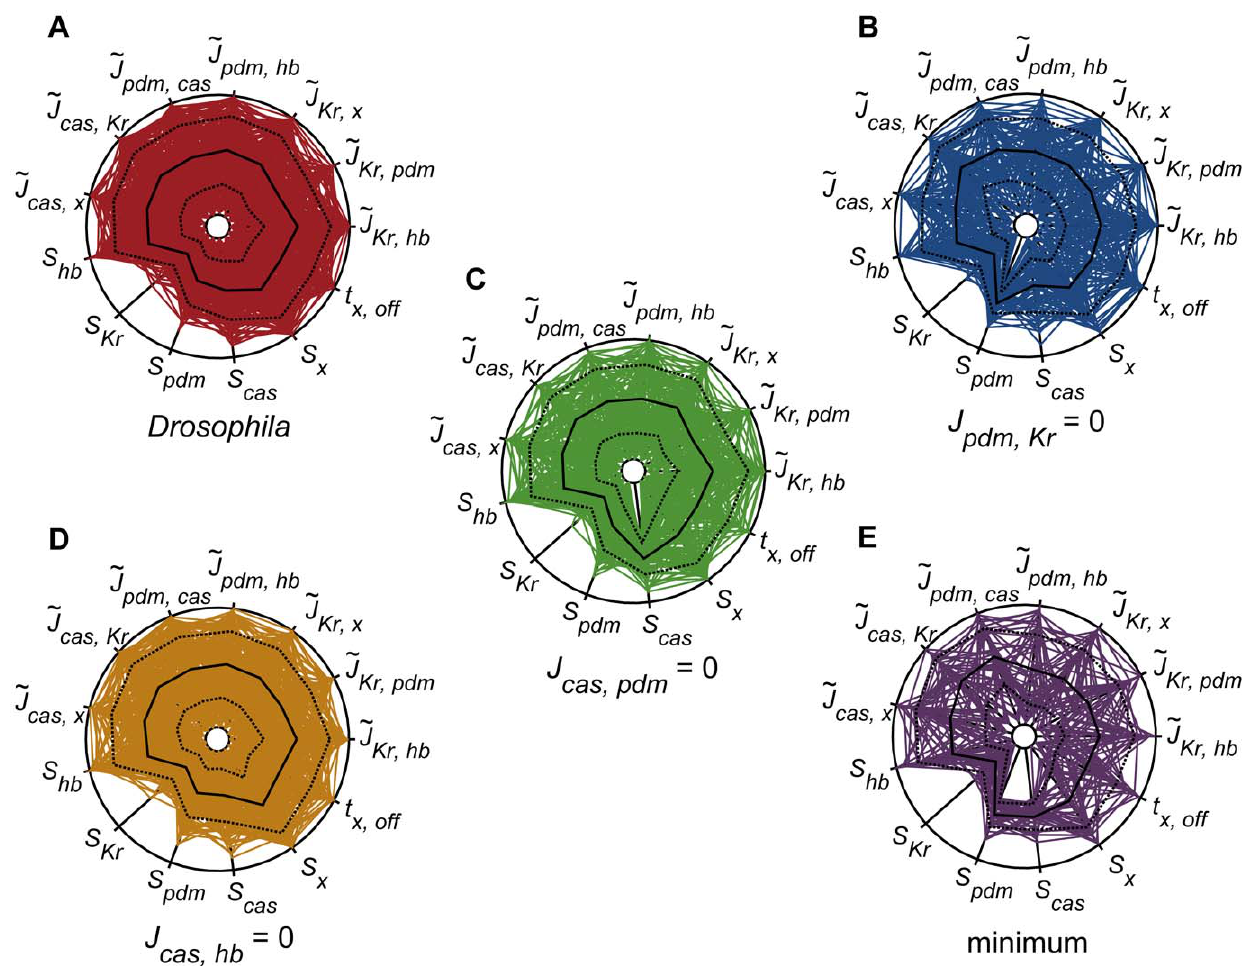
Figure 7. Graphical representation of parameter sets with which the WT sequential expression profile is reproduced. ( A ) The Drosophila network, the networks lacking ( B ) activation from Kr to pdm , ( C ) activation from pdm to cas , ( D ) repression from hb to cas , and ( E ) the minimum network. The parameters involved in minimum network are shown. Each spoke represents a value of indicated parameter between the range used for random parameter assignment (Table 4). The value of t x , off is shown by normal scale and those of the other parameters are shown by log scale. Each polygon indicates one parameter set. Solid and broken lines indicate mean and s.d. of obtained parameters. The data are drawn from 5,000 trials of the random assignment of parameter values.